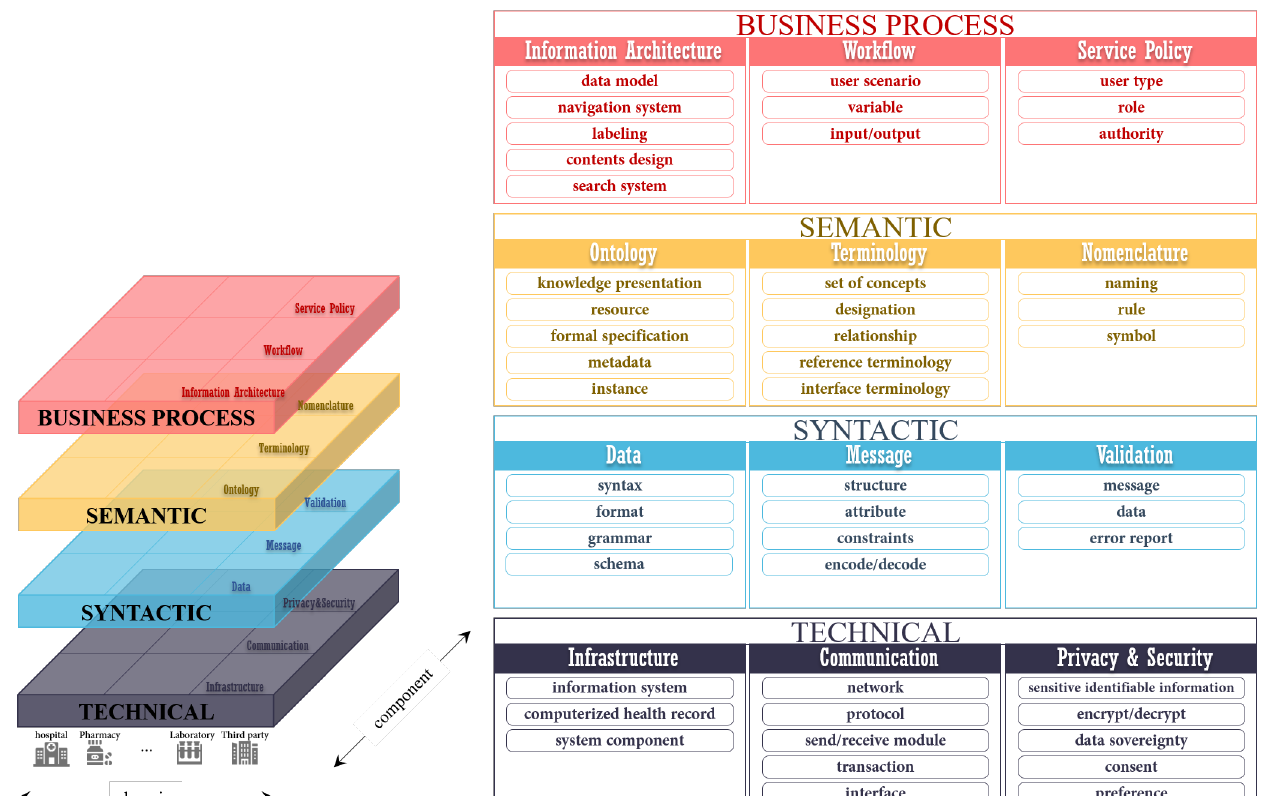
Figure 2. Layered level-specific